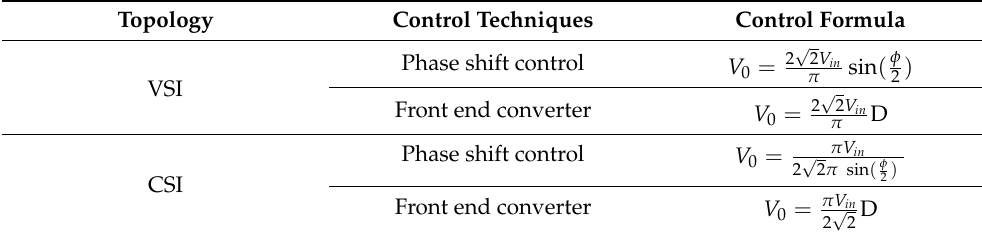
Table 3. Various converter topologies.